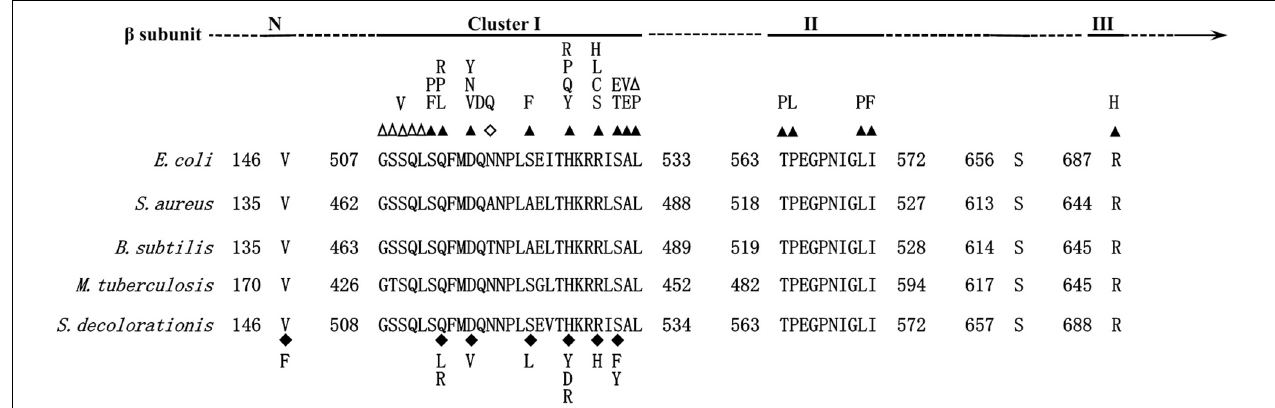
FIGURE 1 | Map of the S. decolorationis RNAP β (RpoB) subunit. (Top) Location of Rif r clusters I, II, and III. (Bottom) Amino acid sequence alignment of the Rif r clusters between E. coli , Staphylococcus aureus , Bacillus subtilis , Mycobacterium tuberculosis , and S. decolorationis . The numbering begins from the first amino acid of the RpoB sequences. Well-characterized RpoB substitutions that cause rifampicin resistance in E. coli are noted above the E. coli RpoB sequence. Closed triangles above the E. coli sequence indicate amino acid substitutions; empty triangles indicate amino acid deletions; empty diamonds indicate amino acid insertions; closed diamonds below the S. decolorationis sequence indicate amino acid substitutions in the S. decolorationis RpoB sequence.